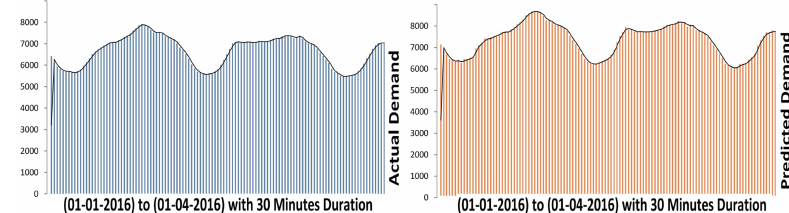
Figure 5. Actual and Predicted demand for few months from AEMO